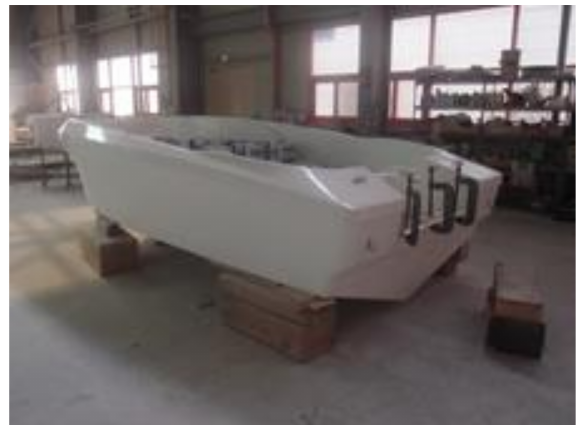
Figure 17. Final manufactured prototype.